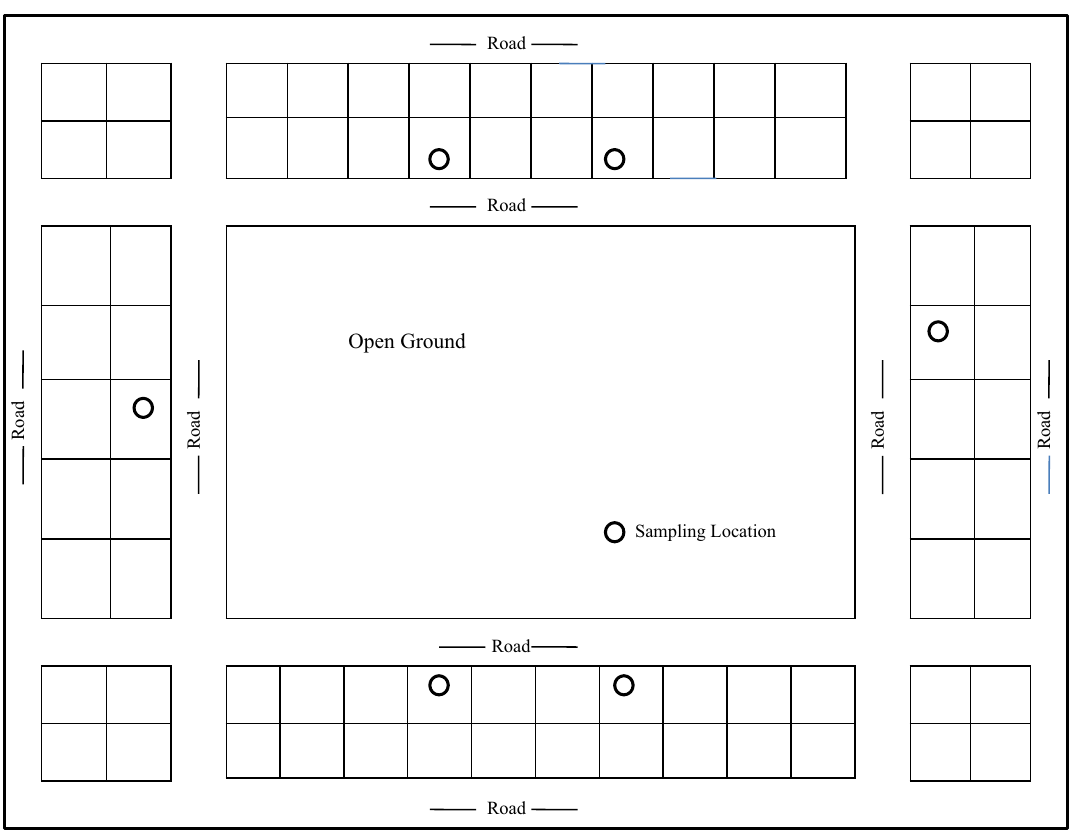
Fig. 2 Schematic map (not to scale) of sampling locations in Pandav Nagar,